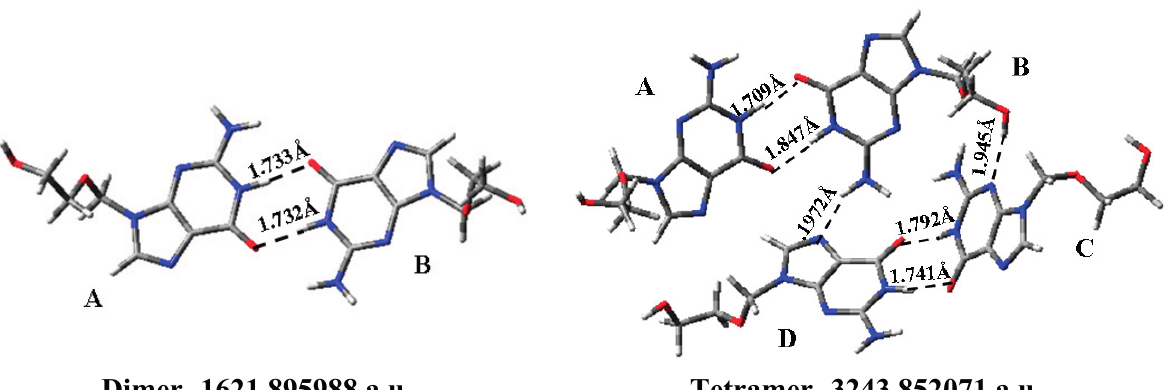
Dimer -1621.895988 a.u. Tetramer -3243.852071